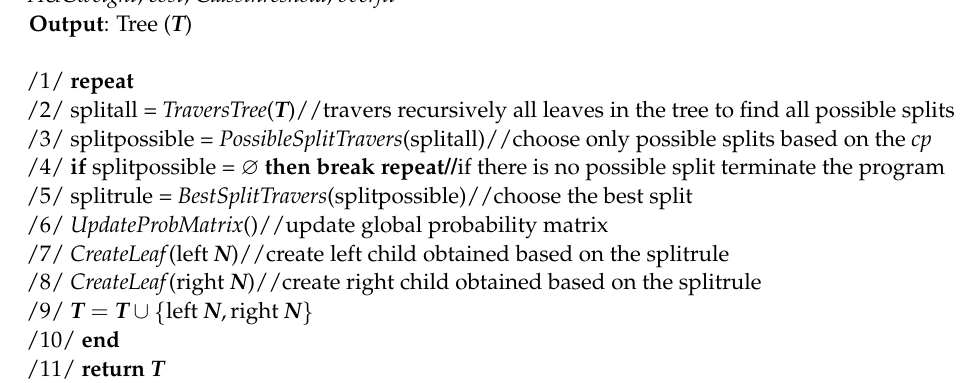
Algorithm 3. BuildTreeAUC